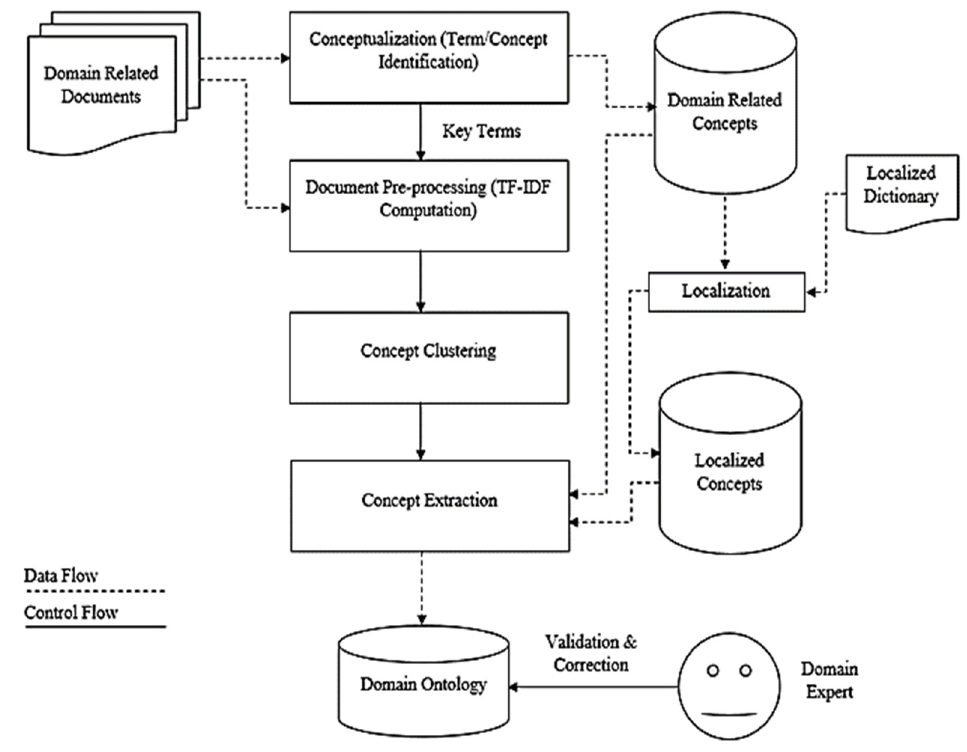
Figure 2. Phases in the proposed EC-DOC.